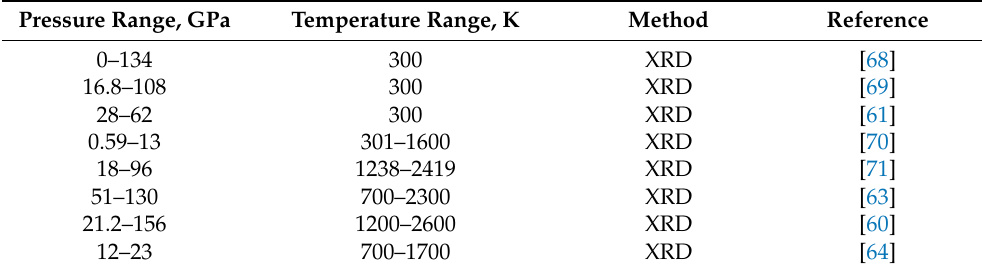
Table 3. Direct experimental measurements of molar volume of CaSiO 3 -perovskite.